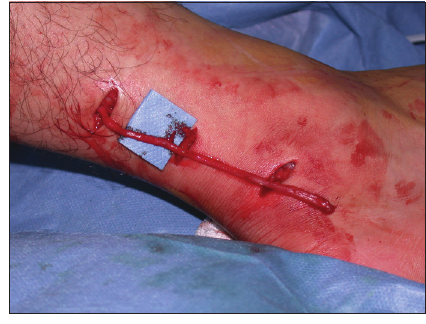
Figure 3. The distal end was divided, and the nerve was then pulled out through the proximal incision.